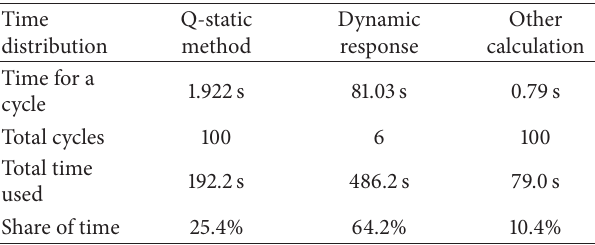
Table 2: CPU time distribution in optimization process.